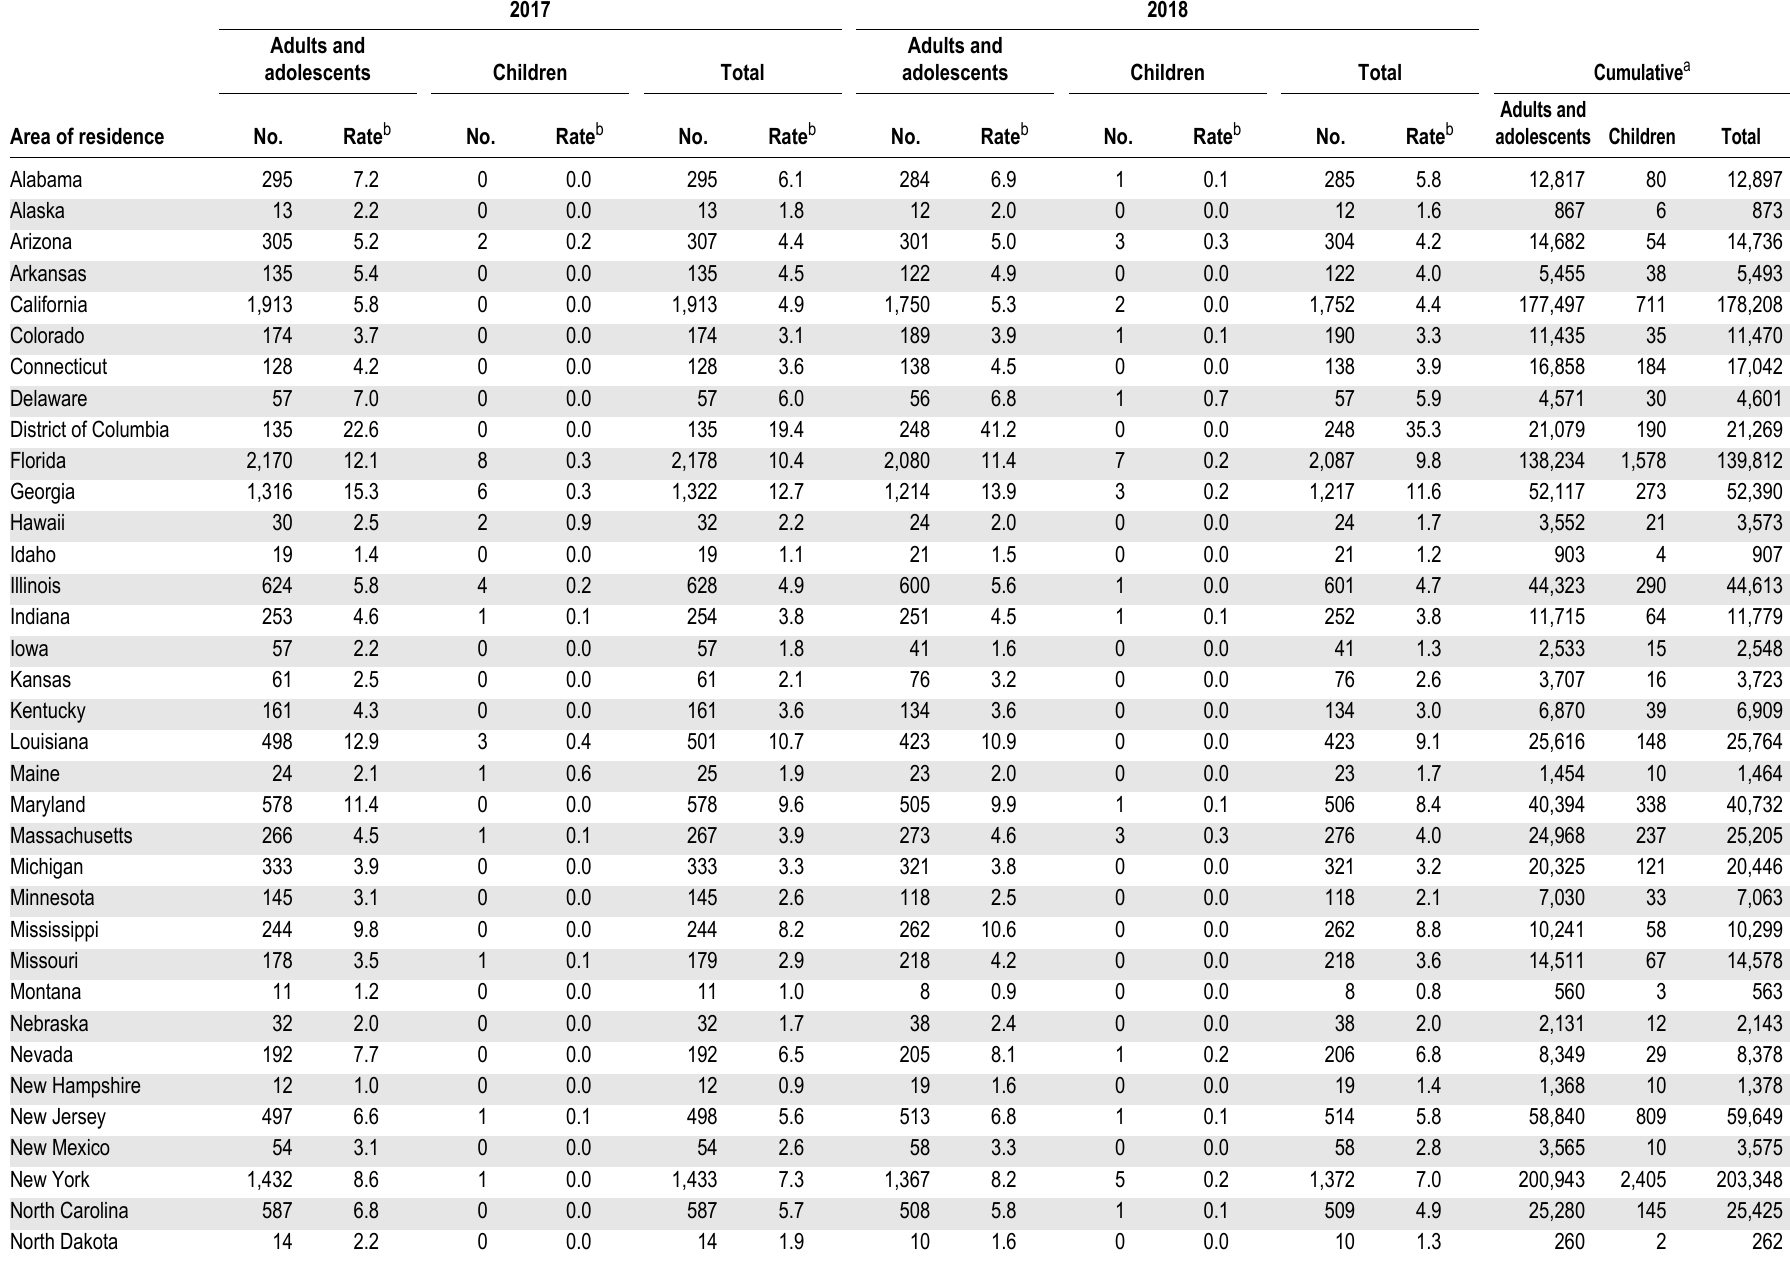
Table 27. Stage 3 (AIDS), by area of residence, 2017, 2018, and cumulative—United States and 6 dependent